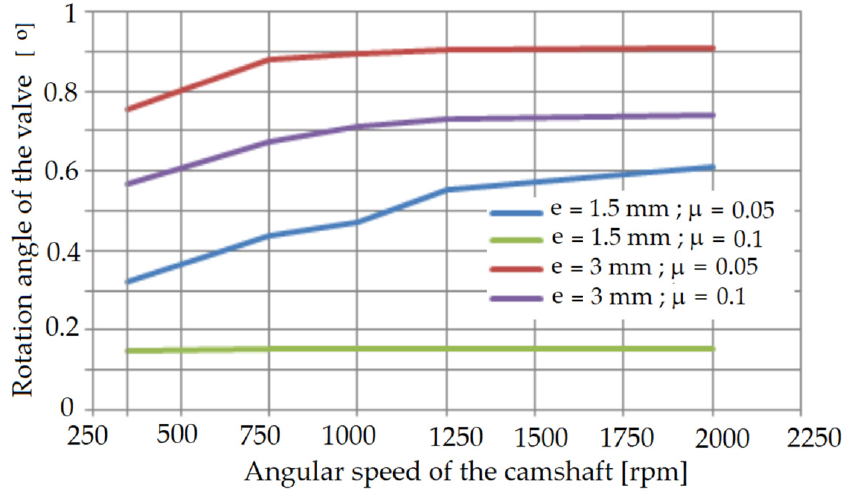
Figure 19. Variation of the valve rotation angle according to camshaft position.